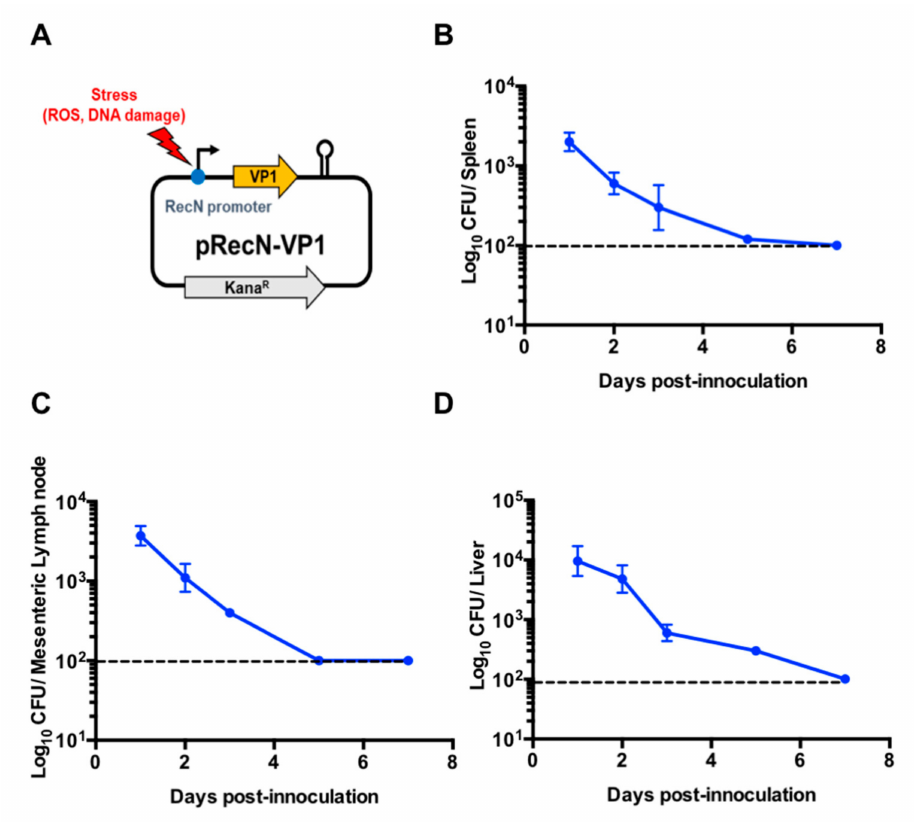
Figure 2. Virulence of Salmonella KST0666, containing pRECN-VP1 (KST0669). ( A ) Schematic plasmid map of stress- inducible VP1-expressing plasmid, pRECN-VP1. ( B – D ) In Vivo virulence of KST0669. The colonization capacity of KST0669 in mice was measured in the spleen ( B ), the mesenteric lymph node ( C ), and the liver ( D ). BALB/c mice ( n = 5 per group) were orally administrated 1 × 10 8 CFU of KST0669, and euthanized on day 1, 2, 3, 5, and 7 post-infection. Bacterial viability was assessed in organ lysates that were serially diluted and plated on LB agar plates. Results are presented as mean ± SEM per group. The interrupted line indicates the undetectable level of bacteria. ROS, reactive oxygen